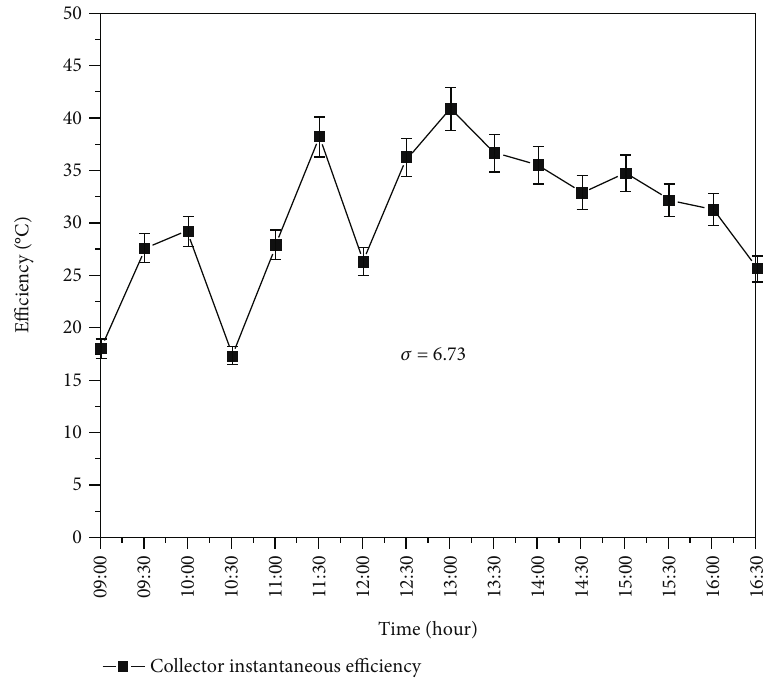
Figure 13: Variation of instantaneous e ffi ciency of the fl at plate